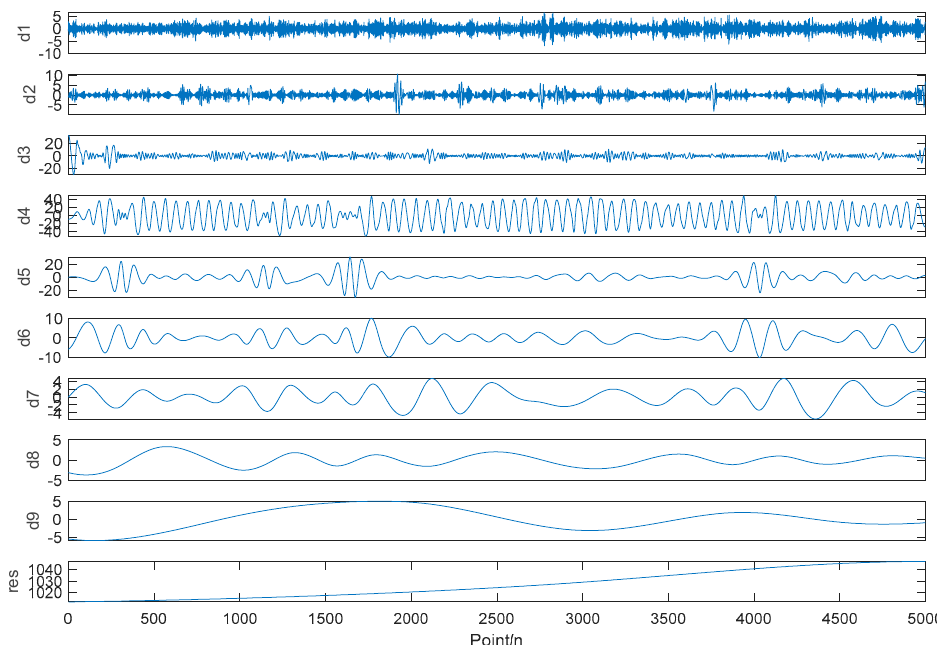
Figure 5. Mold-level data EMD results. d i is the i -th IMF, the unit of d i is mm, n is the number of Point, res is residual .